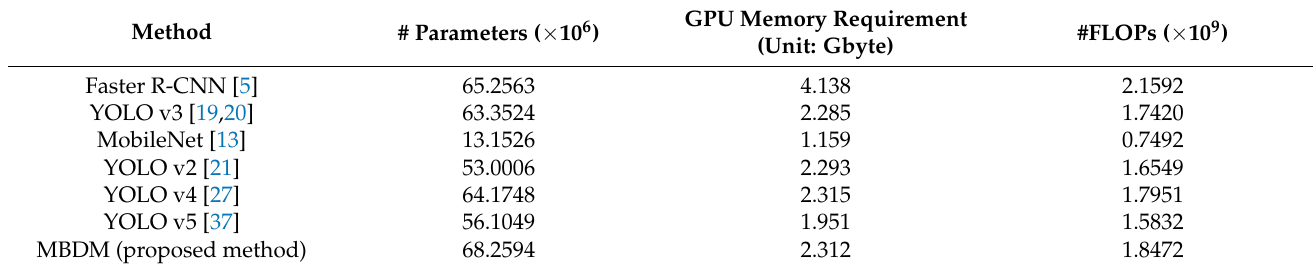
Table 14. Comparisons of number of parameters, GPU memory requirement, and